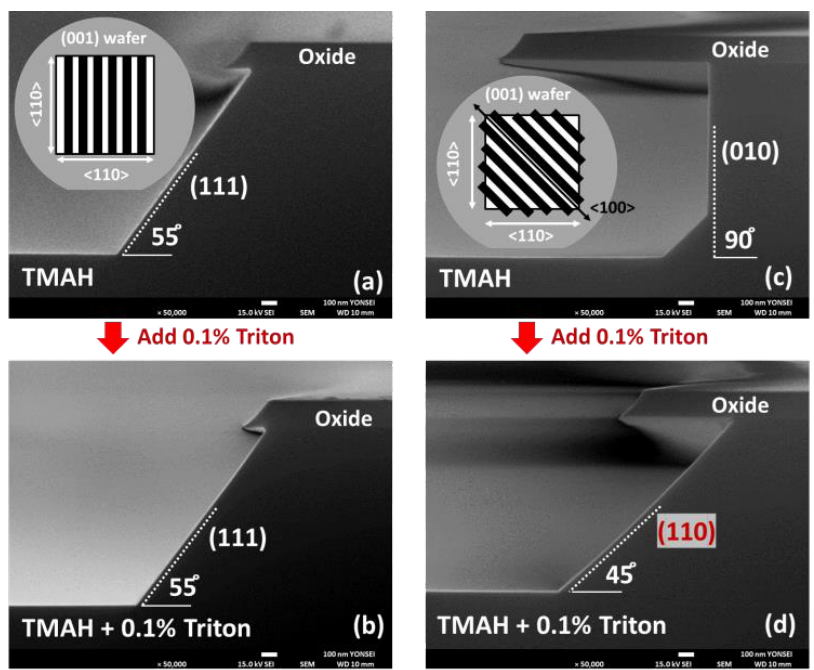
Figure 5. Cross-sectional SEM images of <110>-patterned oxide wafer after 9 min etching in ( a ) TMAH and ( b ) TMAH with 0.1 vol% Triton and <100>-patterned oxide wafer after 9 min etching in ( c ) TMAH and ( d ) TMAH with 0.1 vol% Triton. Table 1. Anisotropic etching rates of Si for various surface orientations in pure 25 wt% tetramethyl ammonium hydroxide (TMAH) with and without 0.1 vol% Triton in the patterned oxide wafers.